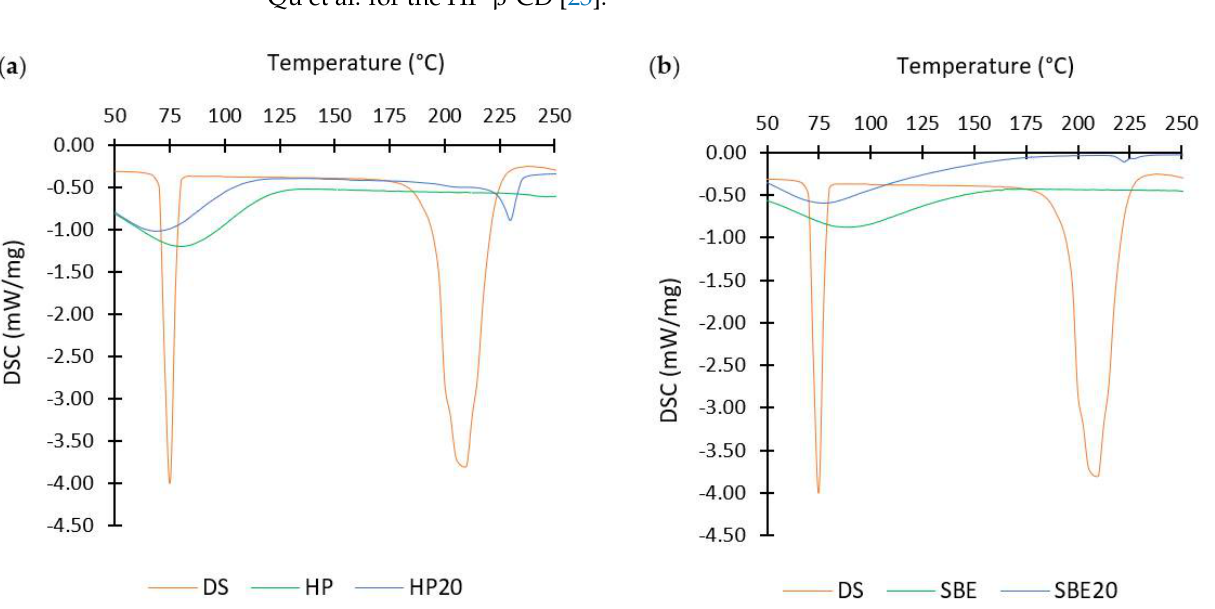
Figure 4. Differential Scanning Calorimetry (DSC) thermographs of ( a ) DS, HP-CD, and freeze-dried formulation (HP20); ( b ) DS, SBE-CD, and the freeze-dried formulation SBE20.